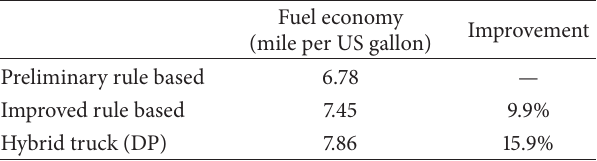
Table 2: Fuel economy